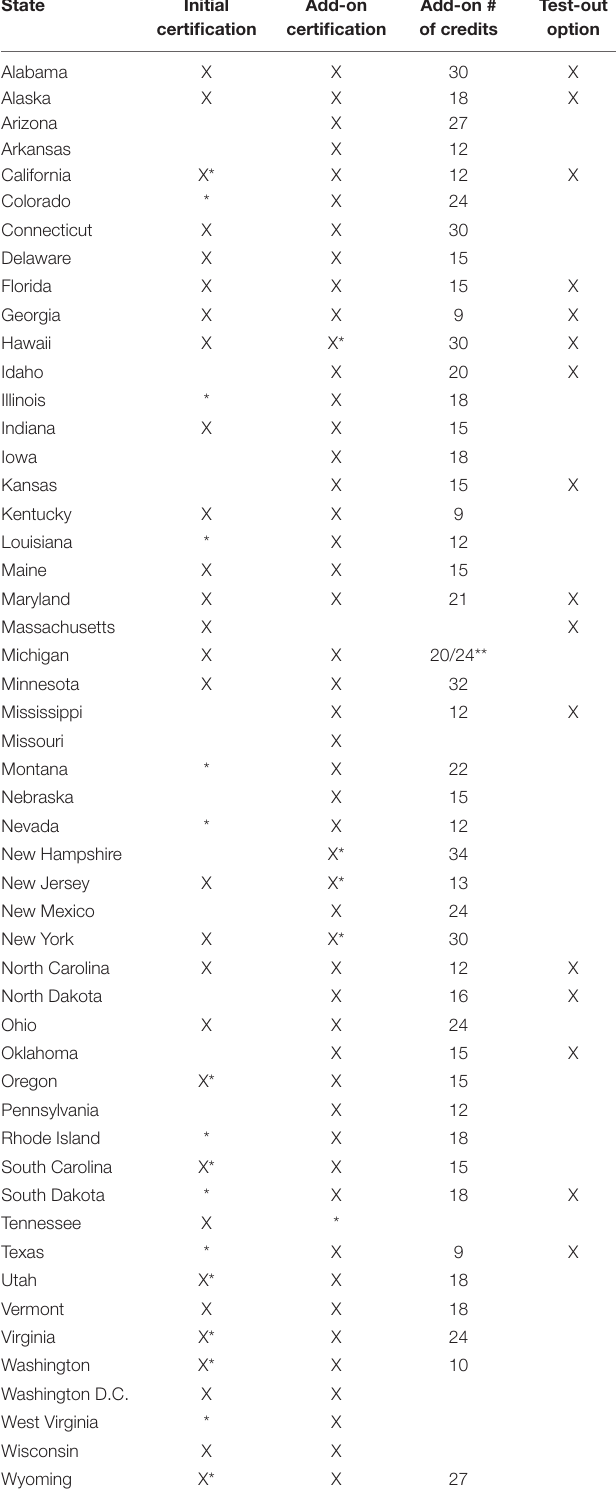
TABLE 1 | State policies for K-12 ESL teacher